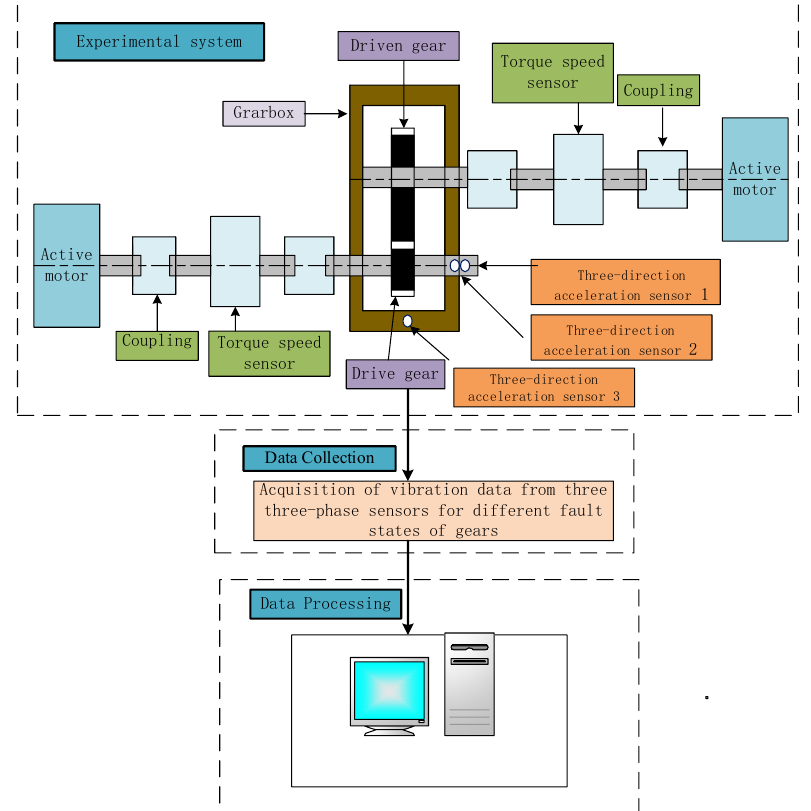
Figure 5. Structural design of the experimental gear.